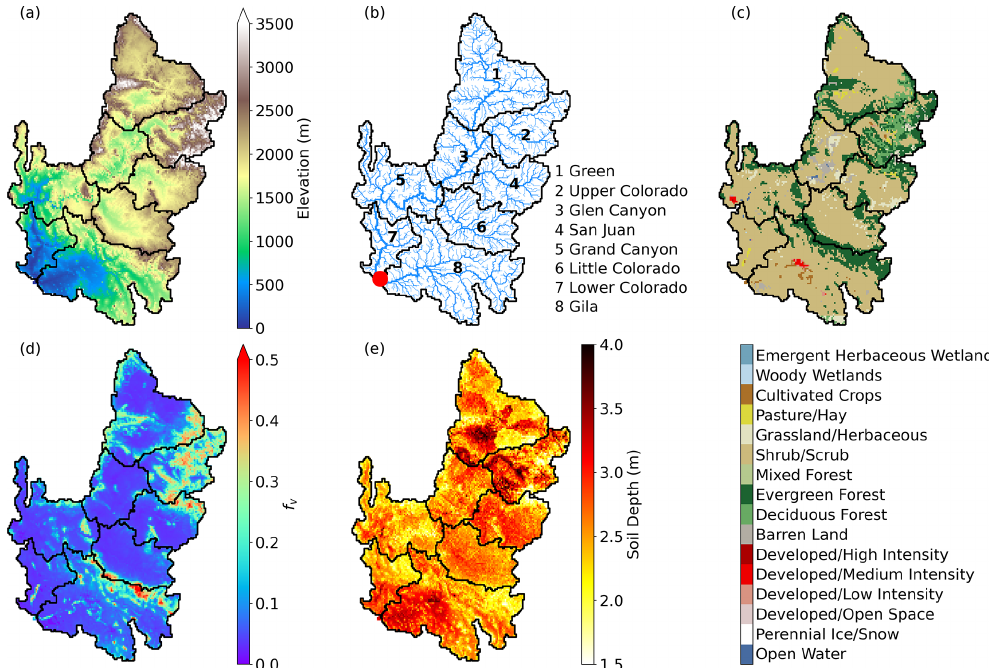
Figure 1. (a) Digital elevation model of the CRB. (b) Channel network and eight subbasins analyzed in this study. The red circle marks Imperial Dam. (c) Dominant vegetation type in each pixel indicated in the legend. (d) Time-averaged vegetation fraction, f v . (e) Total soil depth. All maps are at 0.0625 ◦ ( ∼ 6km) spatial resolution. Values of f v and soil depth are from the baseline simulation. Table 1. Spatially averaged mean annual precipitation ( P ), snow water equivalent (SWE), runoff ( Q ), and runoff ratio ( Q/P ), along with area, mean elevation, mean soil depth, and percentage of trees in the CRB and its subbasins. CRB Green Upper San Glen Little Grand Lower Gila Colorado Juan Canyon Colorado Canyon Colorado P (mmyr − 1 ) 350.9 405.5